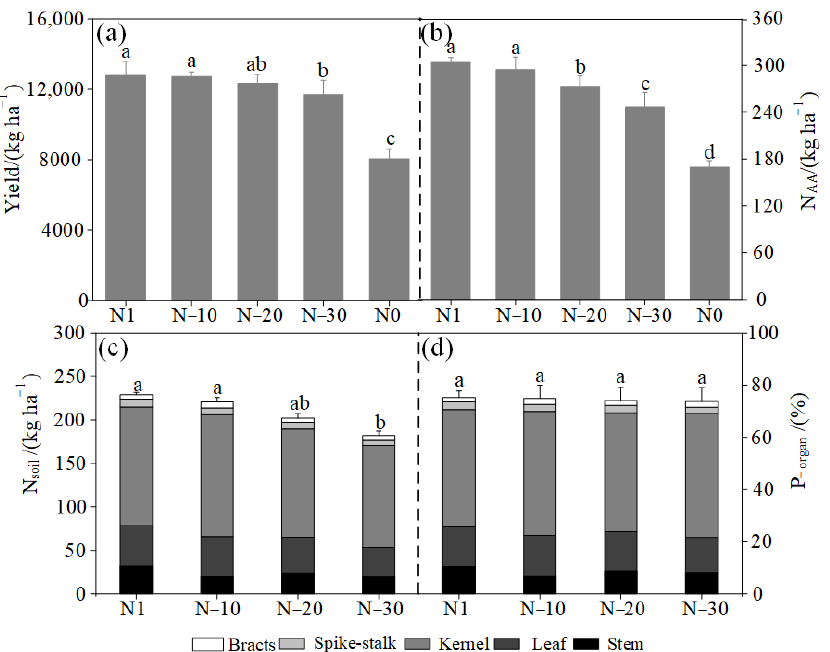
Figure 2. Corn yields ( a ), nitrogen accumulation ( b ), soil nitrogen accumulation ( c ), and ratios of soil nitrogen accumulation to plant nitrogen accumulation under the different treatments ( d ). Note: different letters indicate significant differences ( p < 0.05). N0, N1, N-10, N-20 and N-30 represent the five fertilization